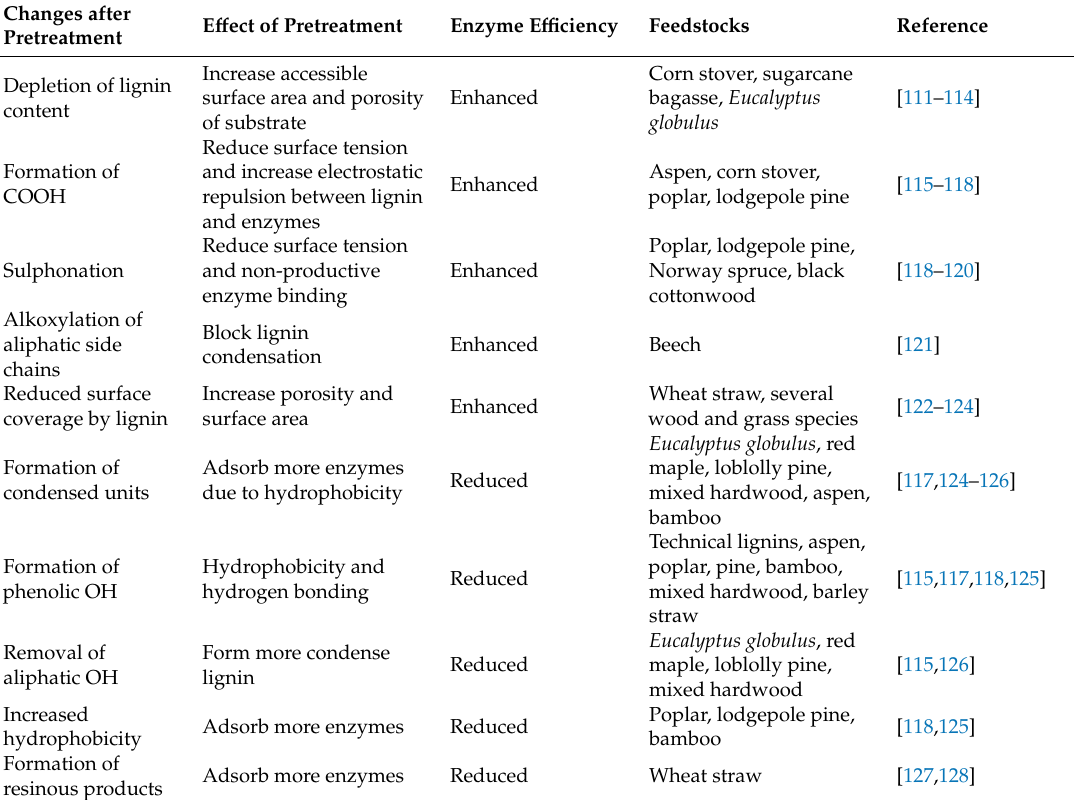
Table 1. Alteration of lignin structure during pretreatment and their e ff ects on enzymatic hydrolysis of pretreated